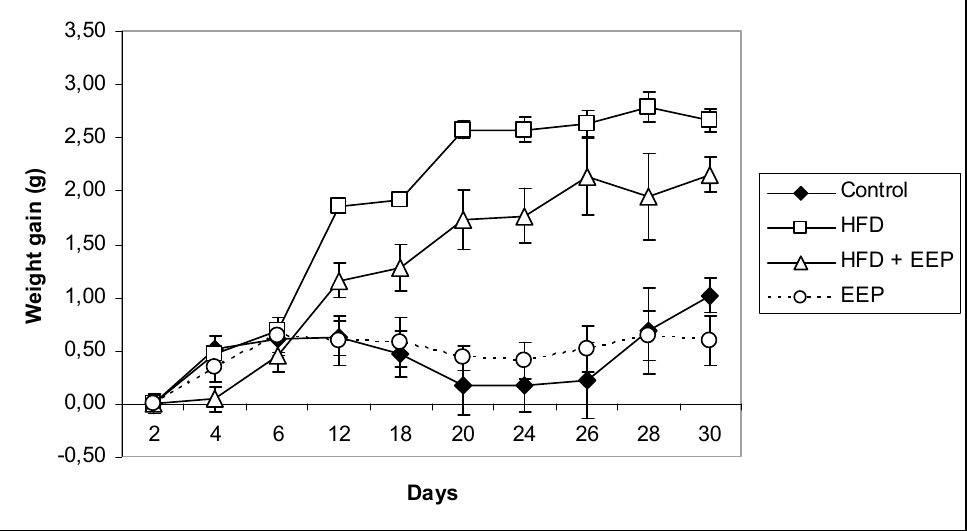
Figure 4. E ff ect of ethanol extract of propolis on weight gain in high-fat diet (HFD) fed mice. Mice were given HFD, HFD + EEP at dose 50 mg / kg or EEP (50 mg / kg) once daily for 30 days by a single intragastric application. Data are presented as the mean ± SD. Number of mice per groups: nine. Table 3. Weight gain, food intake, food e ffi ciency ratio (FER) in HFD fed mice. Treatments